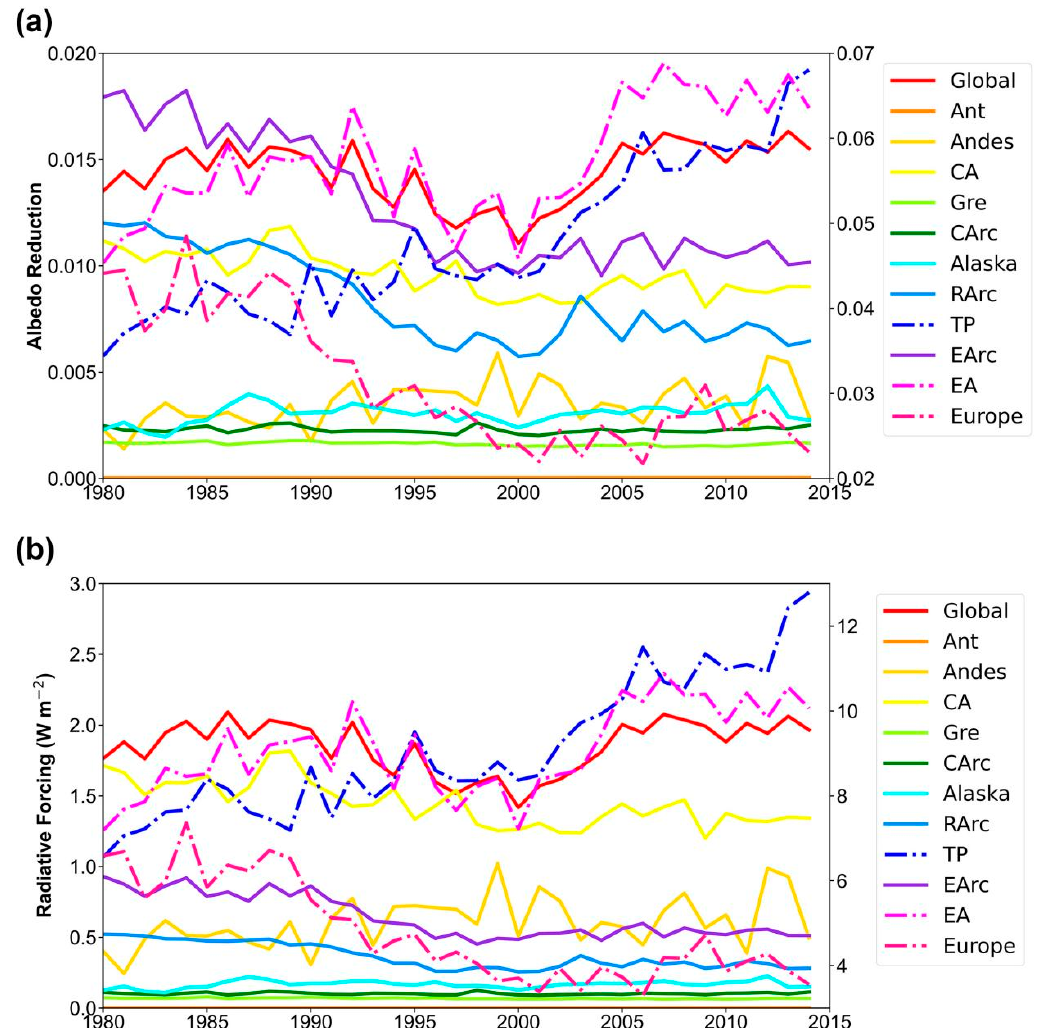
Figure 7. Temporal trends in ( a ) all-sky albedo reduction and ( b ) radiative forcing caused by CMIP6 multi-model mean BC concentrations in snow, globally and regionally during 1980–2014. Values for solid lines are on the left axis and for dashed lines on the right.